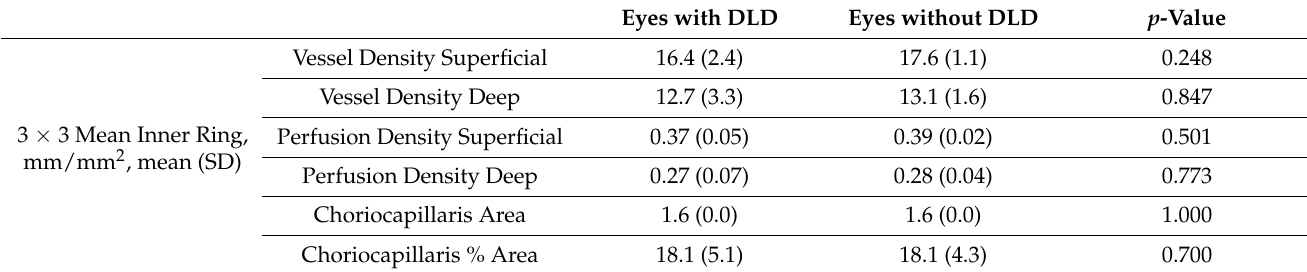
Table 5. Vascular analysis using OCTA. SD, standard deviation. Eyes with DLD Eyes without DLD p -Value